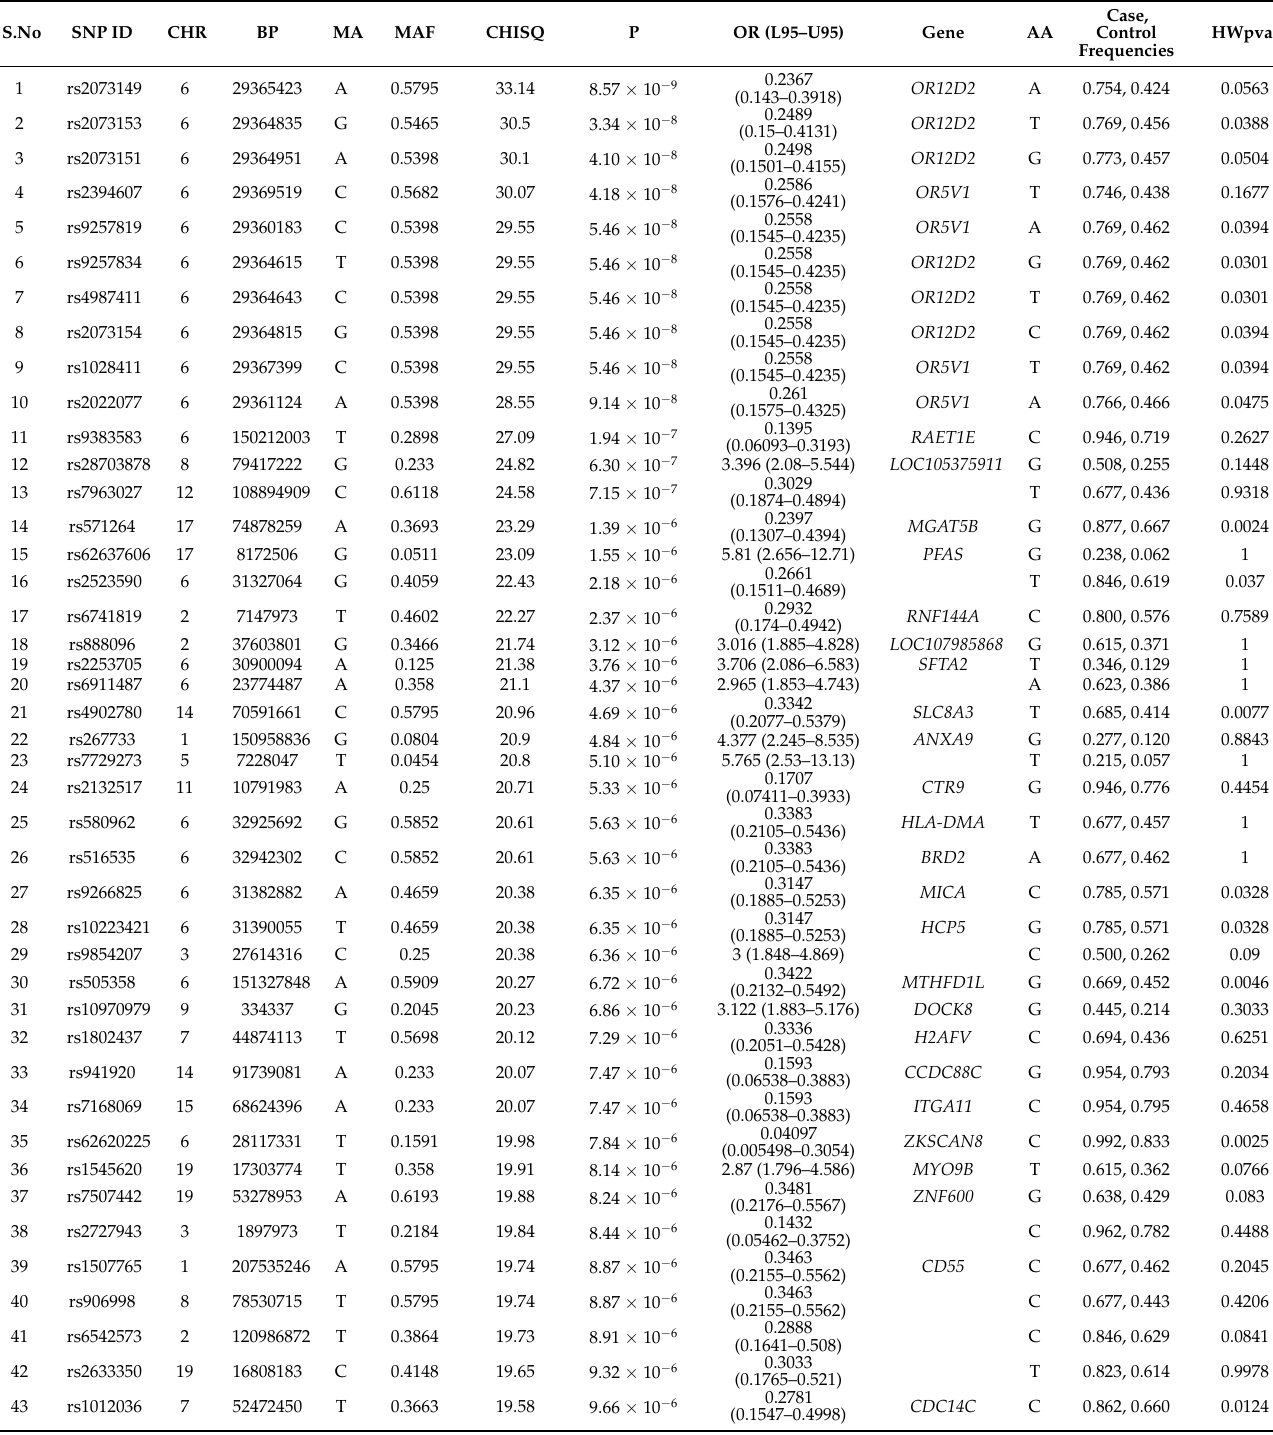
Table 1. List of the most significant SNPs associated with autistic